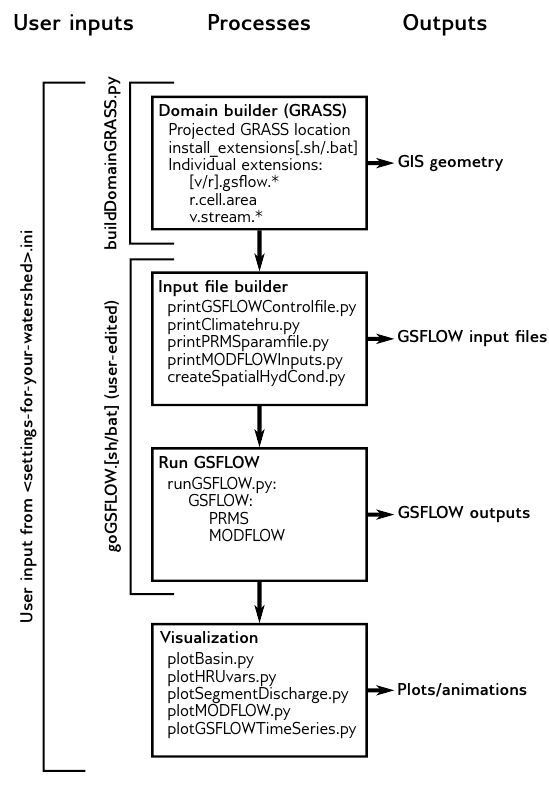
Figure 3. GSFLOW–GRASS